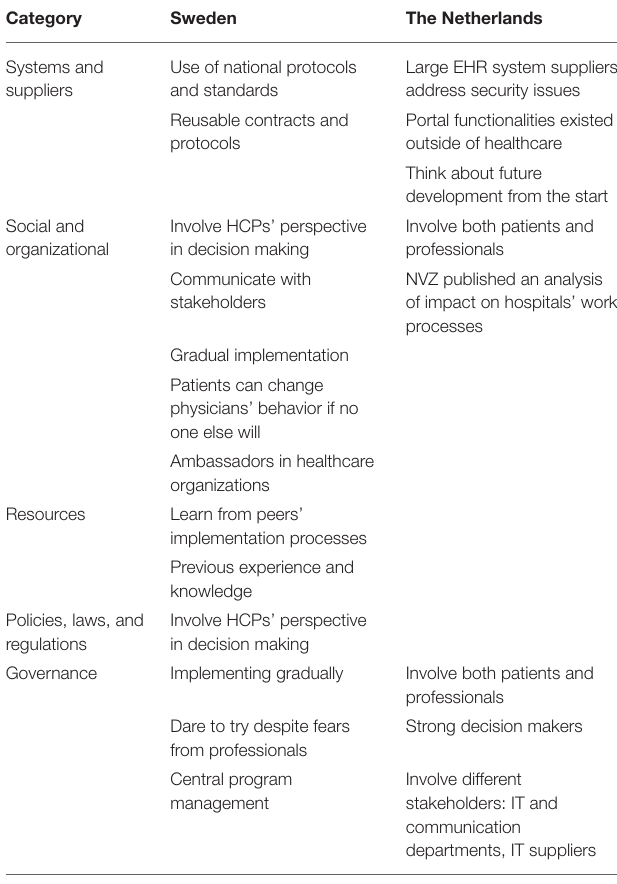
TABLE 5 | Facilitators on the national level. Category